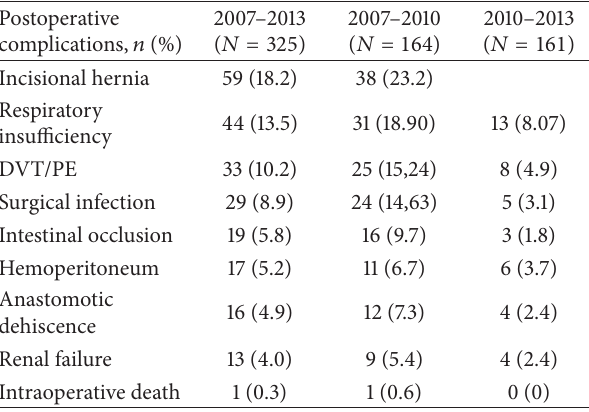
Table 5: Postoperative complications for the 325 patients during the study period associated with the bariatric